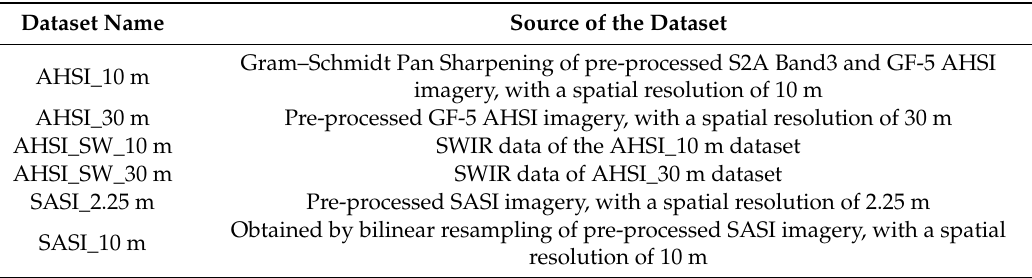
Table 5. Detailed introduction of six datasets.